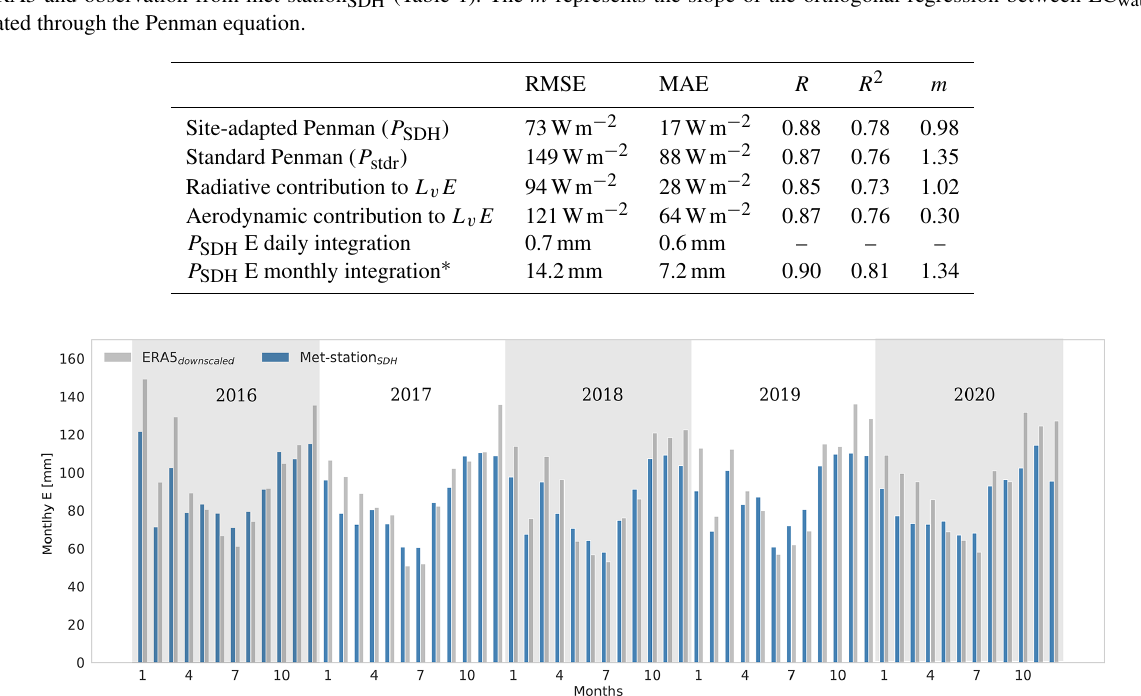
Figure 5. Monthly integrated evaporation obtained through the site-adapted Penman equation using ERA5 and met-station SDH standard meteorological data during the 2016–2020